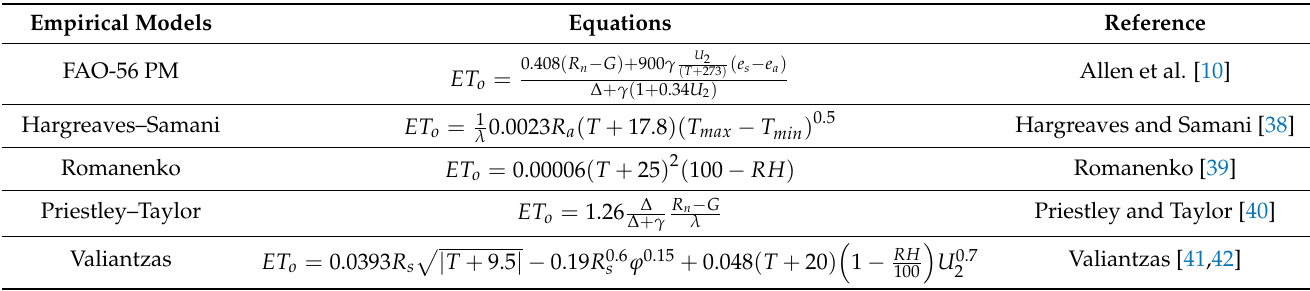
Table 2. The original forms of empirical models applied in this study.